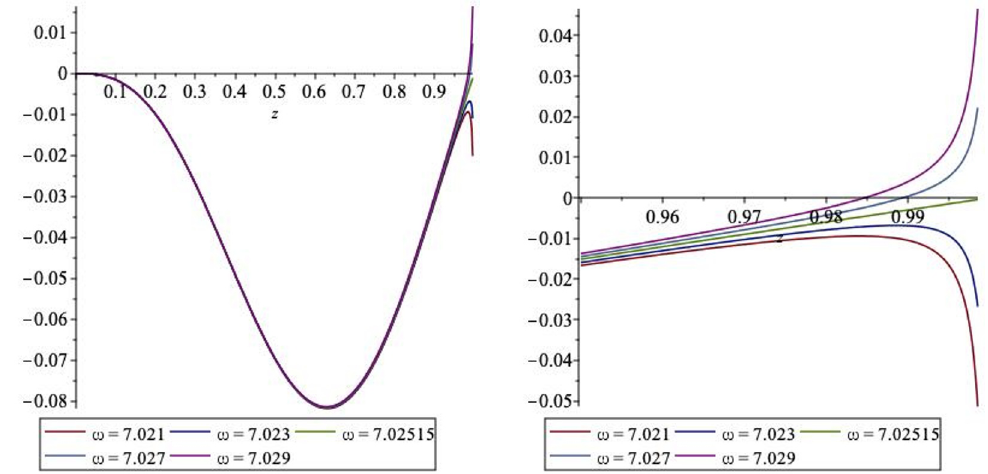
Figure 11. Illustration of procedure for determining allowed frequencies ω . We plot solutions φ m,ω ( x ) with m = 1 consistent with normalizability at z = 0 , for various values of ω . We have chosen ML = 1 for concreteness. The figure on the left shows the full range of z , while the figure on right shows a close-up in the vicinity of z = 1